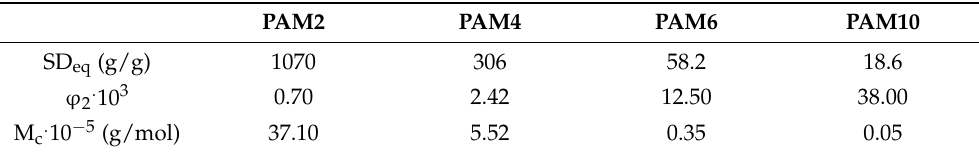
Table 1. Hydrogels Table 1. Hydrogels characteristics.